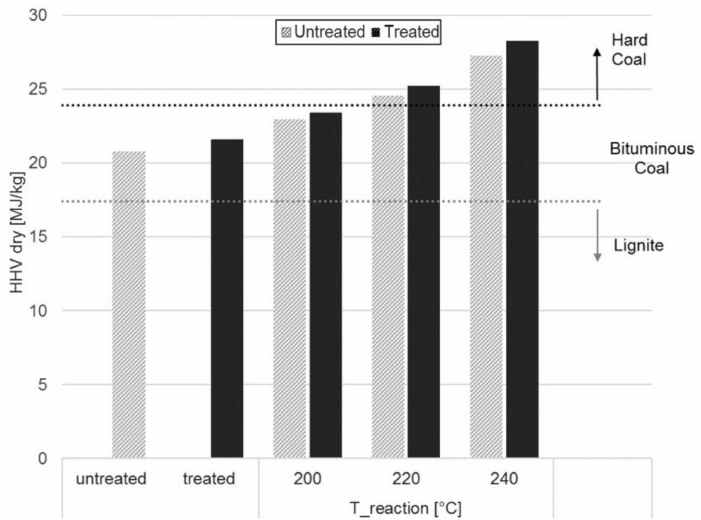
Figure 3. Higher heating value of hydrothermal carbonization experiments as a function of reaction temperature for untreated wood and treated